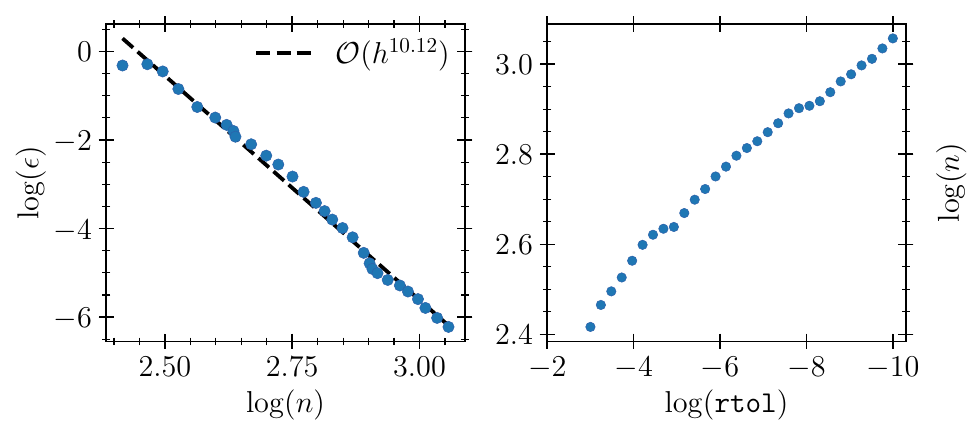
Figure 4: Absolute error ε for the two-site tight-binding model Eq. (46) as a func- tion of the number of time-steps n and the number of time-steps as function of the tolerances, with atol = 10 − 2 rtol . The time boundaries were kept fixed (with = 5) and the maximum algorithm order chosen was k J t final dashed line is a linear fit corroborating the error scaling as